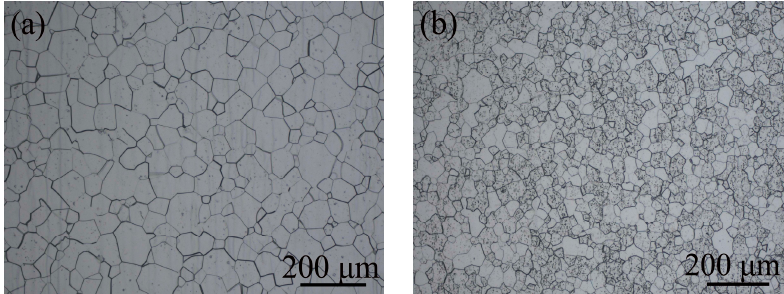
Figure 1. Optical microstructures of the alloys after solution treatment at 800 °C for 1 h: ( a ) alloy C1; ( b ) alloy C2.